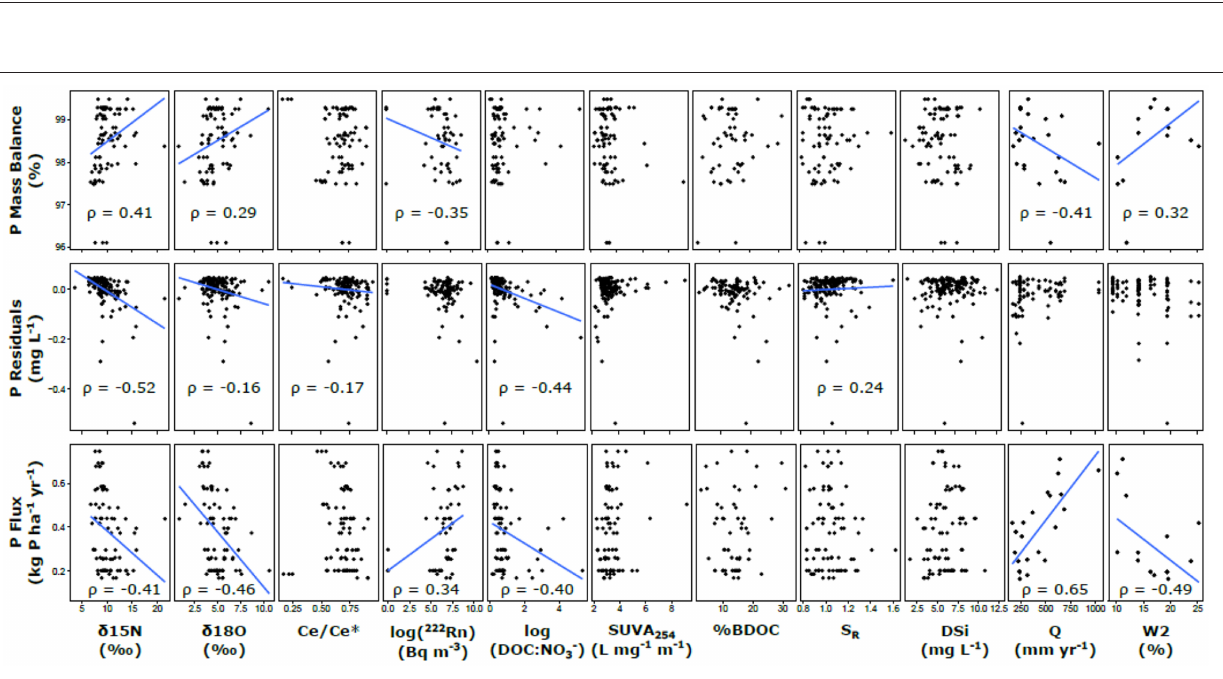
with other hydrological metrics, watershed characteristics, and biogeochemical reactions at multiple spatiotemporal